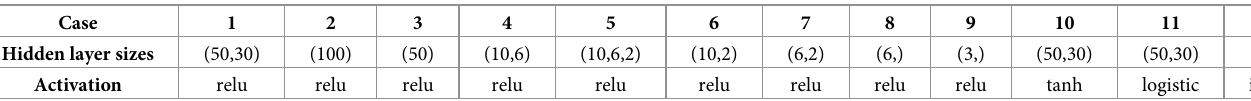
Table 2. Cases at different parameter